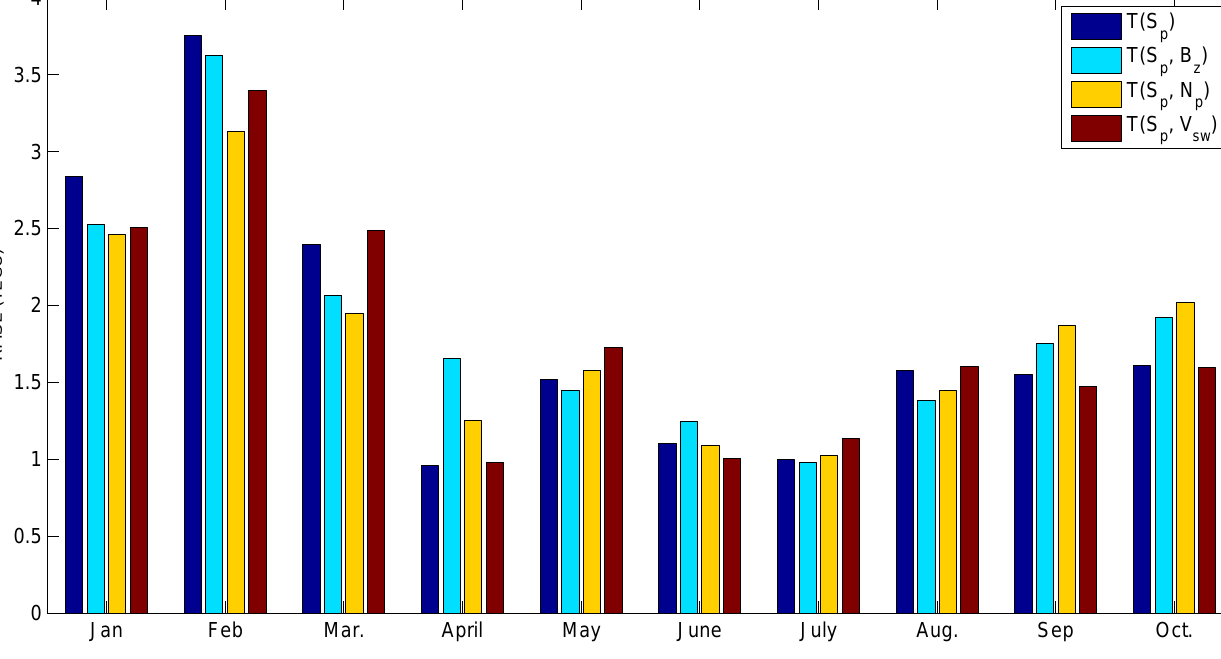
Fig. 11. Computed RMSE values between GPS TEC and predicted TEC for the available months in 2005.